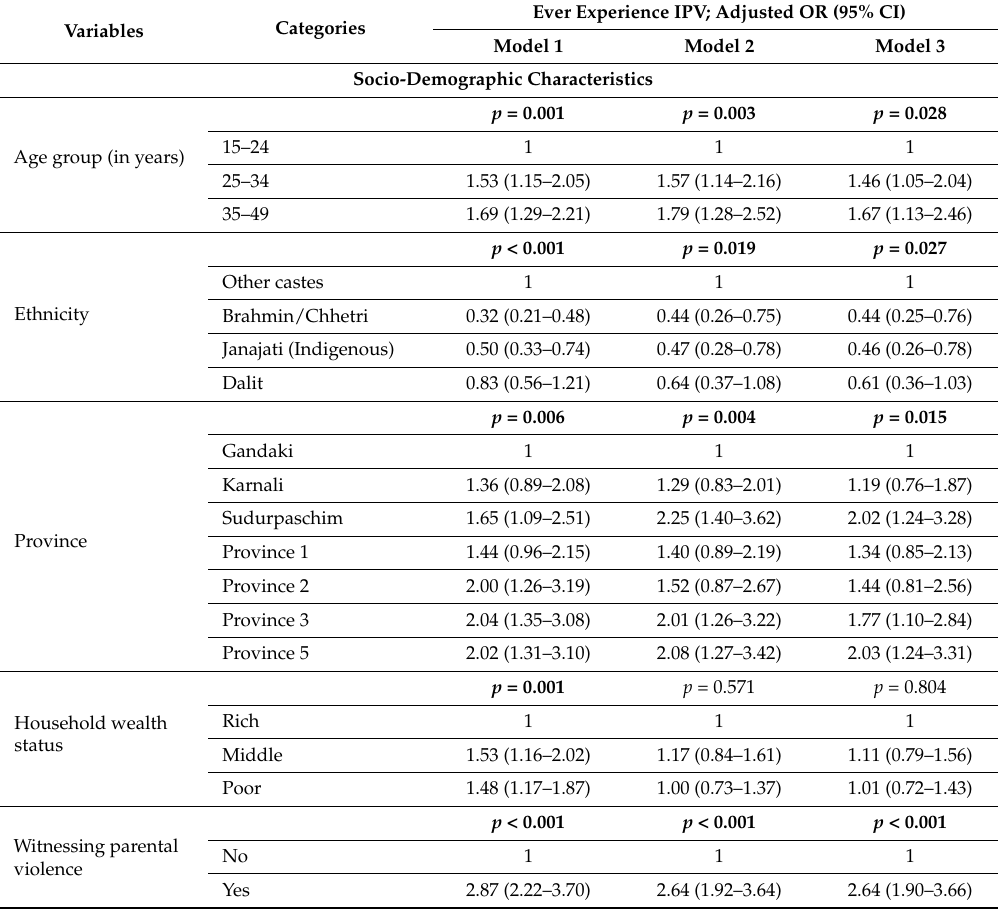
Table 6. Analysis of factors associated with Ever experience of IPV among women in Nepal, 2016